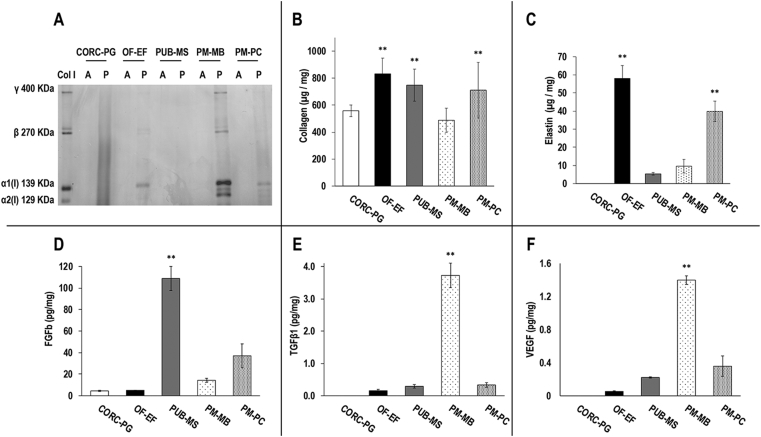
SDS-PAGE analysis of acetic acid (A) and acetic acid/pepsin (P) showed soluble collagen in OF-EF, PUB-MS, PM-MB, and PM-PC (A). Hydroxyproline assay revealed that the OF-EF, PUB-MS, and PM-PC had the highest (∗∗) collagen content (B). OF-EF and PM-PC showed the highest (∗∗) elastin content (C). The PUB-MS had the highest (∗∗) FGF-basic content (D). The PM-MB had the highest (∗∗) TGF-β1 (E) and VEGF (F) content. Data expressed as average ± standard deviation (n = 3). ∗∗Indicates statistically higher (p<0.01) groups.